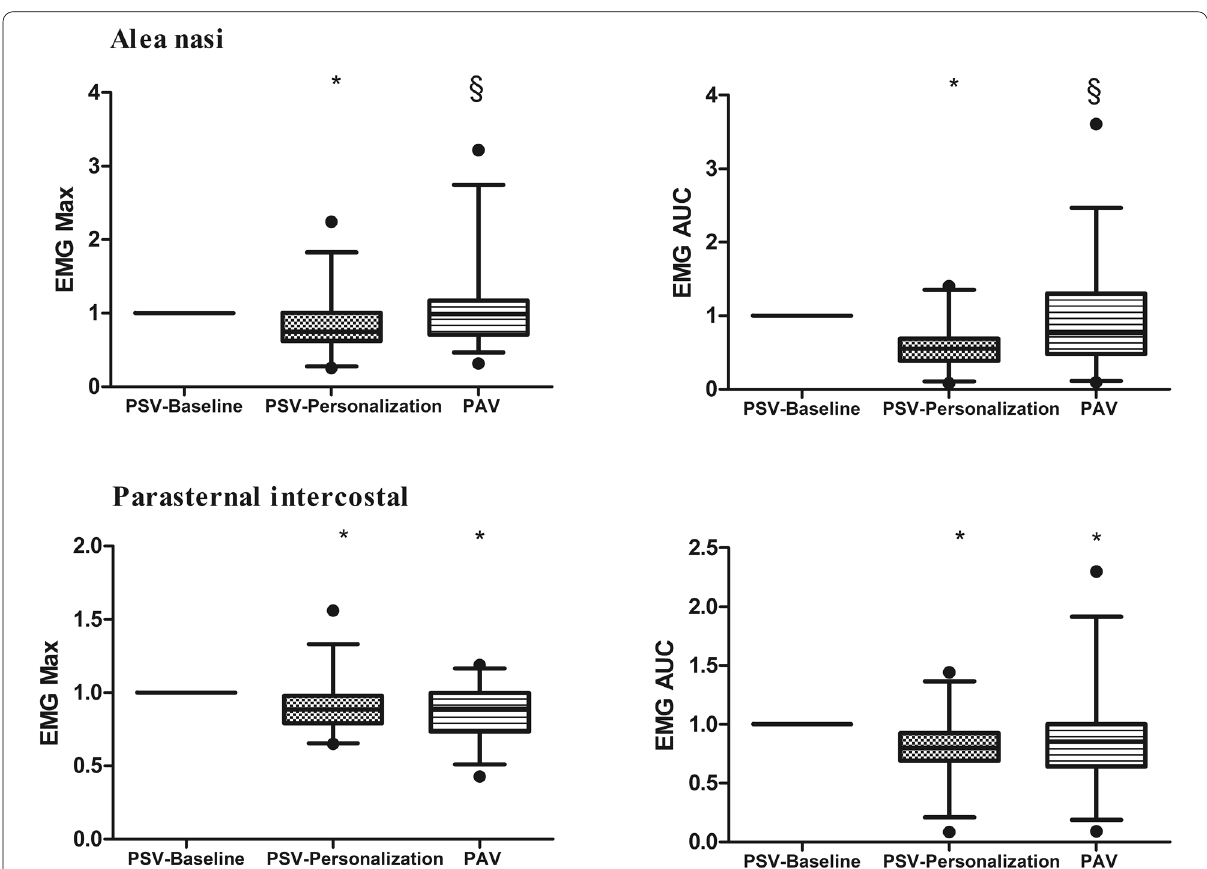
Fig. 2 Electromyographic (EMG) activity of Alae nasi and parasternal intercostal muscles at baseline (PSV‑Baseline), after personalization of ventilator settings (PSV‑Personalization) and with proportional assist ventilation (PAV). The EMG activity is described by peak EMG (EMGmax) and area under the curve (EMGauc) and is expressed as a proportion of the EMG activity under the PSV‑Baseline condition. Line inside the boxes median, limits of the boxes 75th and 25th percentiles of the data (interquartile range), whiskers 5th and 95th percentiles. * p < 0.05 compared to the PSV‑Baseline condition, § p < 0.05 compared to the PSV‑Personalization